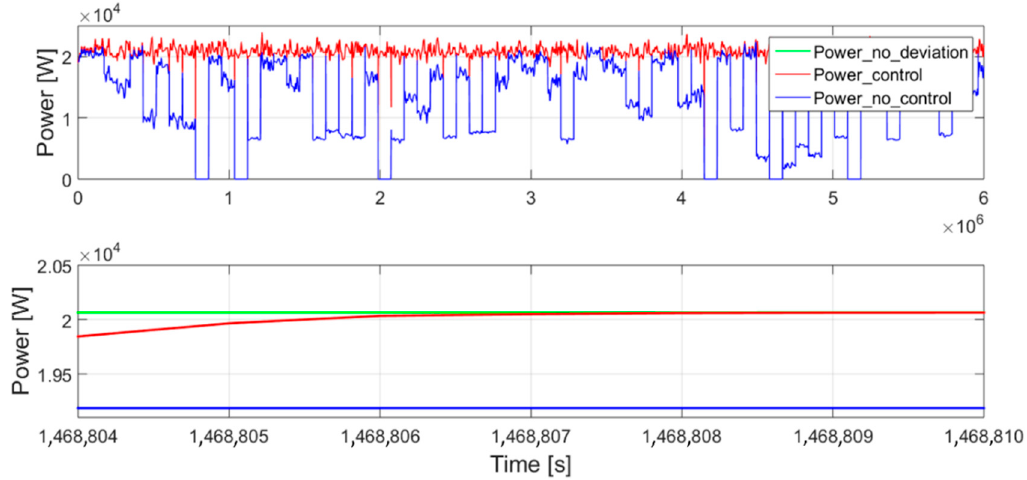
Figure 12. Different scenarios of the generated power for the Q ( s , a ) matrix calculation.